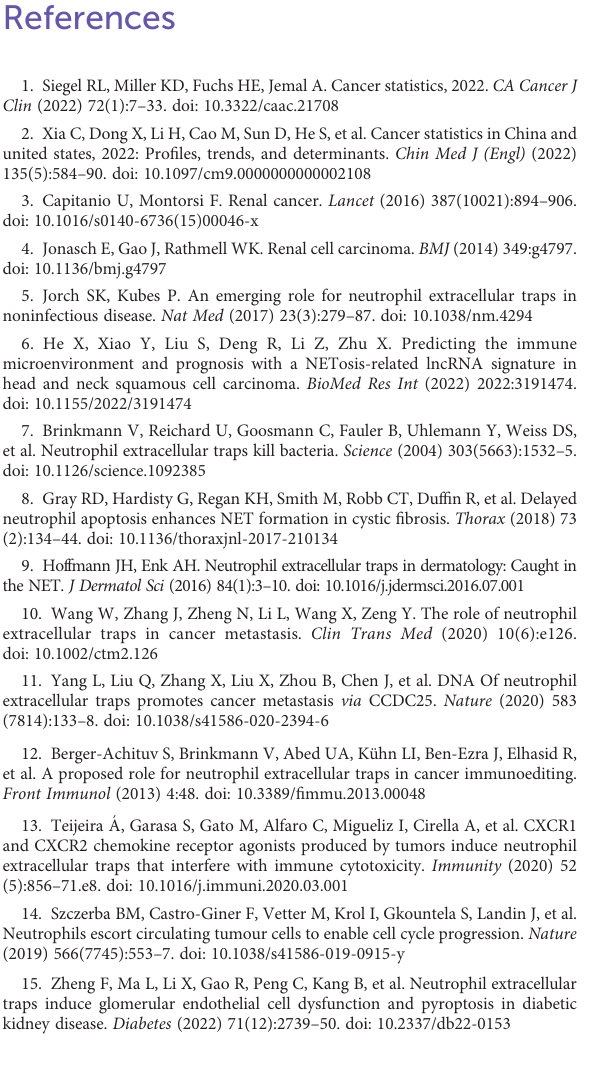
SUPPLEMENTARY TABLE 2 The results of univariate Cox regression for 94 DEGs in ccRCC